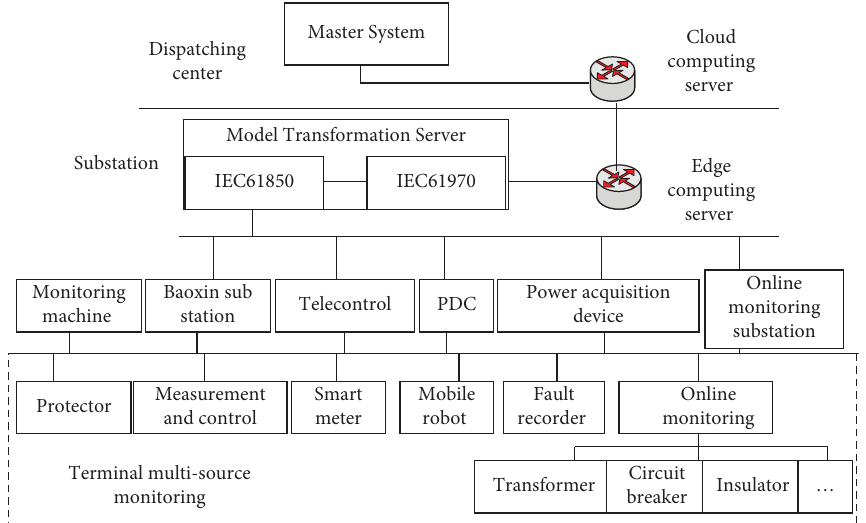
Figure 1: Architecture of substation equipment panoramic perception system based on edge